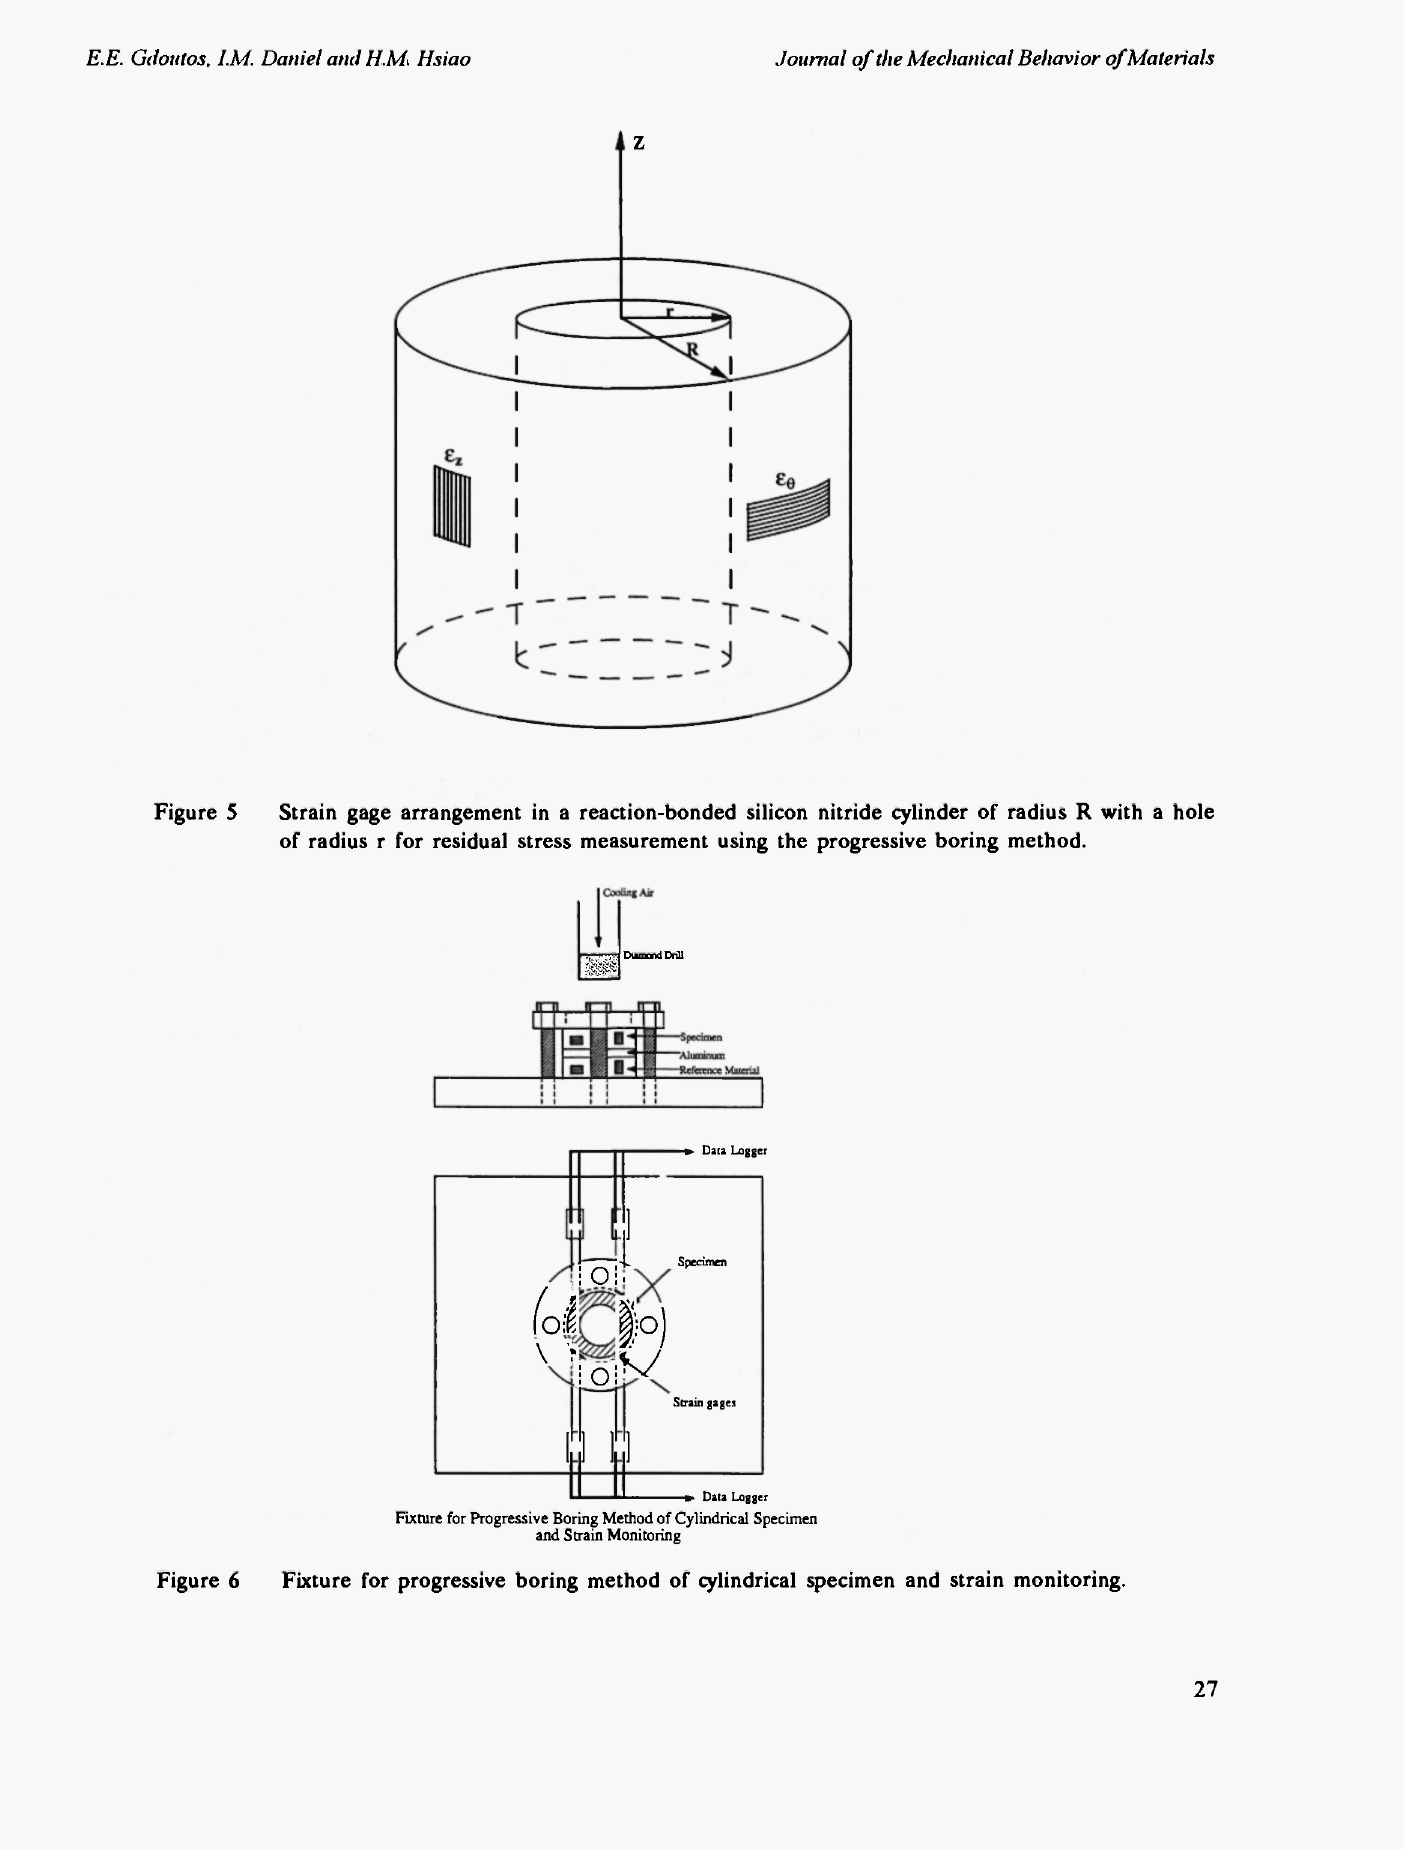
Figure 6 Fixture for progressive boring method of cylindrical specimen and strain